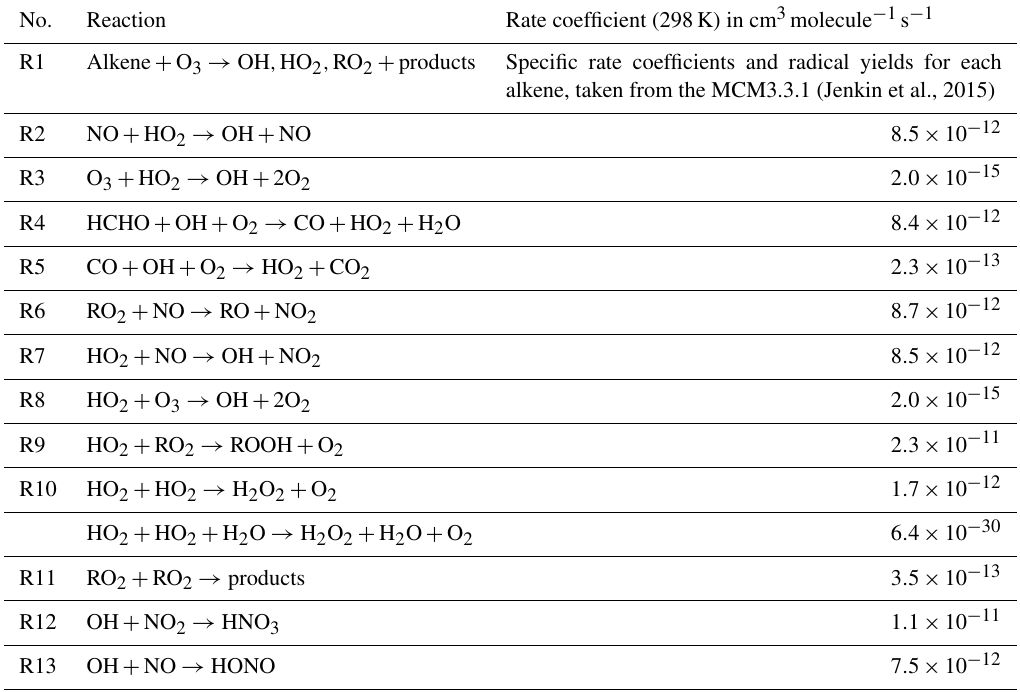
Table 1. Chemical reactions that were used in the experimental budget analysis for OH, HO 2 , RO 2 and RO x . The rate coefficients at 298K are given in column 3; temperature-dependent rate coefficients were used in the experimental budget analysis presented in Sect. 3.3. No.